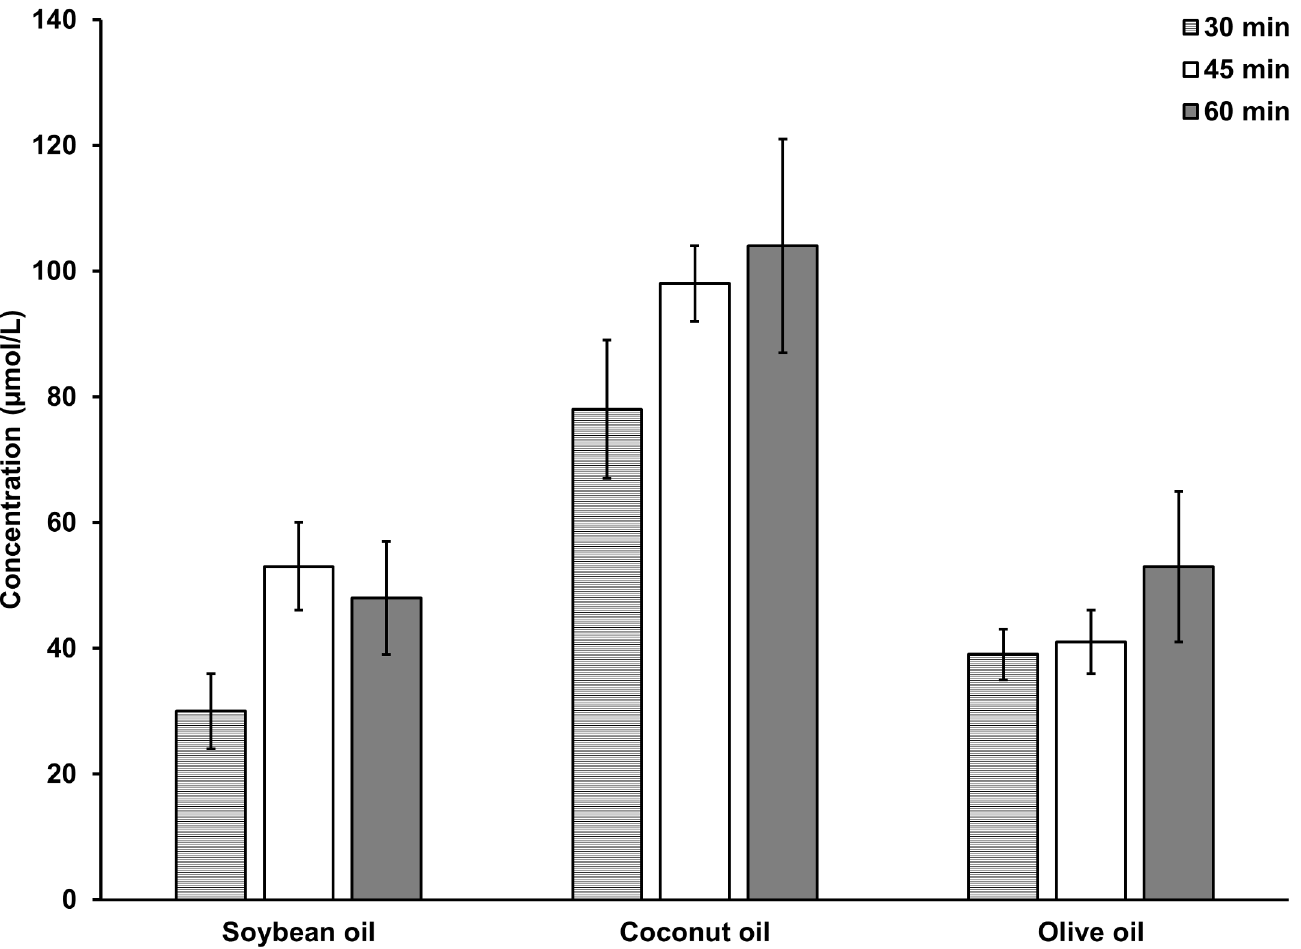
Fig 1. Concentration ( μ mol/L) of caffeic acid in plasma collected after oral feeding and hydrolyzed with sulfatase / β -glucuronidase. Concentration of total caffeic acid in Soybeanoil treated group and the Olive oil treated group were significantly lower comparedto the Coconut oil treated group up to 1 hr after treatment (p < 0.05). n =